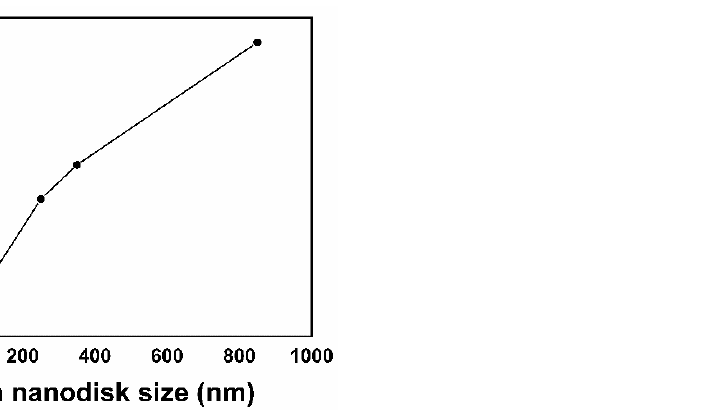
Figure 4. The relationship between the particle size and thickness of the deposited metallic Zn adjusts to a quadratic curve as the deposition time